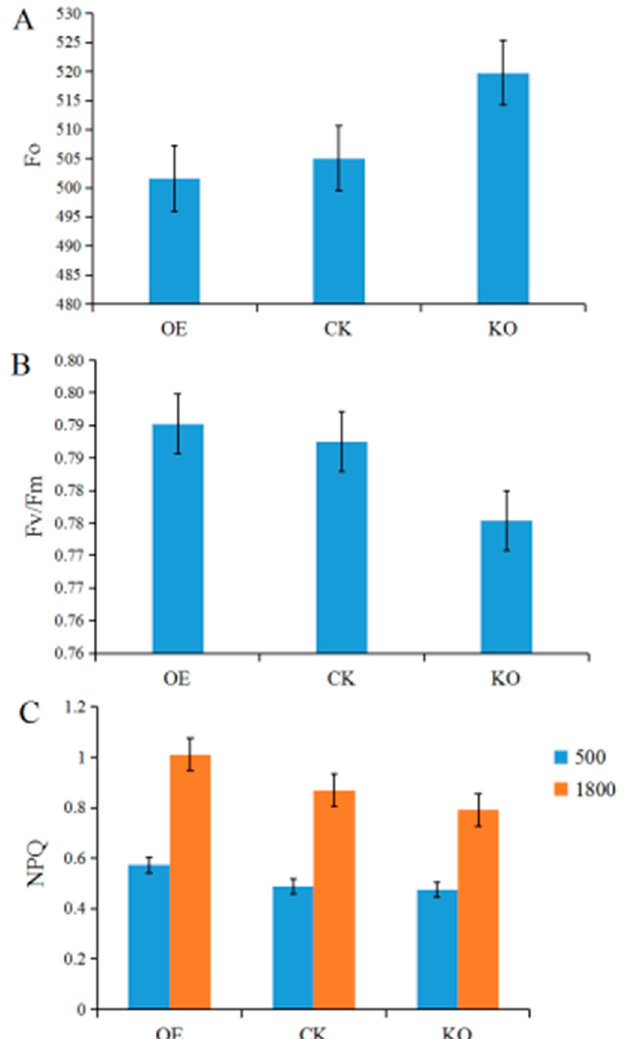
Figure 8. Chl fluorescence kinetic parameters of WT and the T 3 generation of GmRIQ2 - like- OE and -KO transgenic soybean seedlings. ( A ), ( B ), and ( C ) represent the effects of different light intensities on the Fo, Fv/Fm, and NPQ of three types of soybean leaves. Vertical bars represent the SE ( n = 3; each treatment consisted of 30 seedlings).